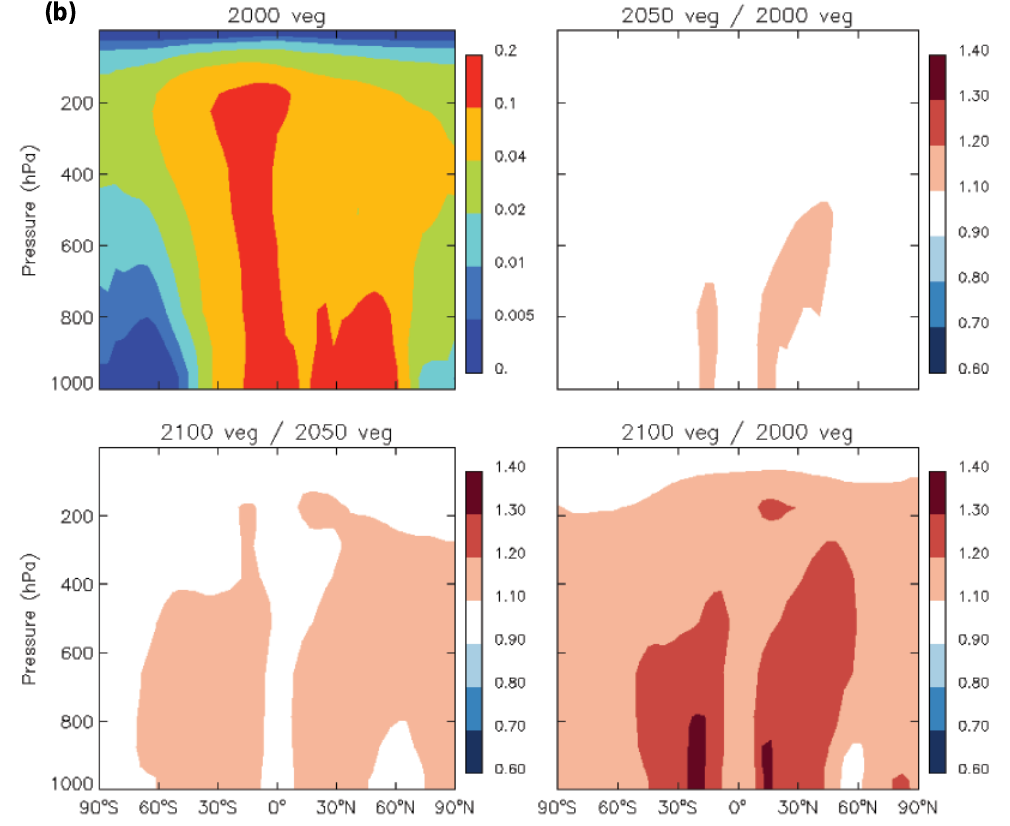
Fig. 4b. Same as Fig. 4a but for zonal